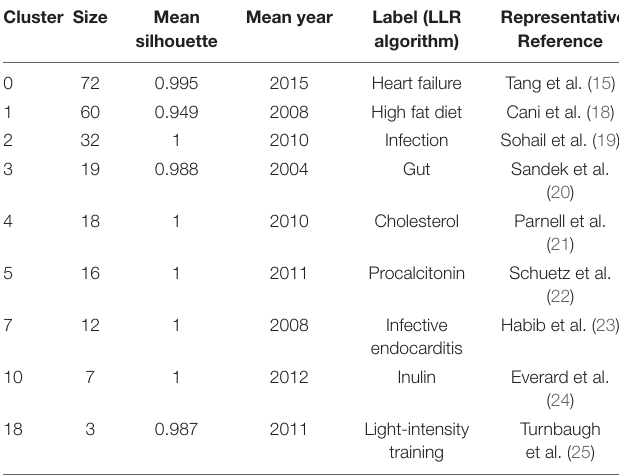
TABLE 4 | The largest nine clusters in the reference co-citation network. Cluster Size